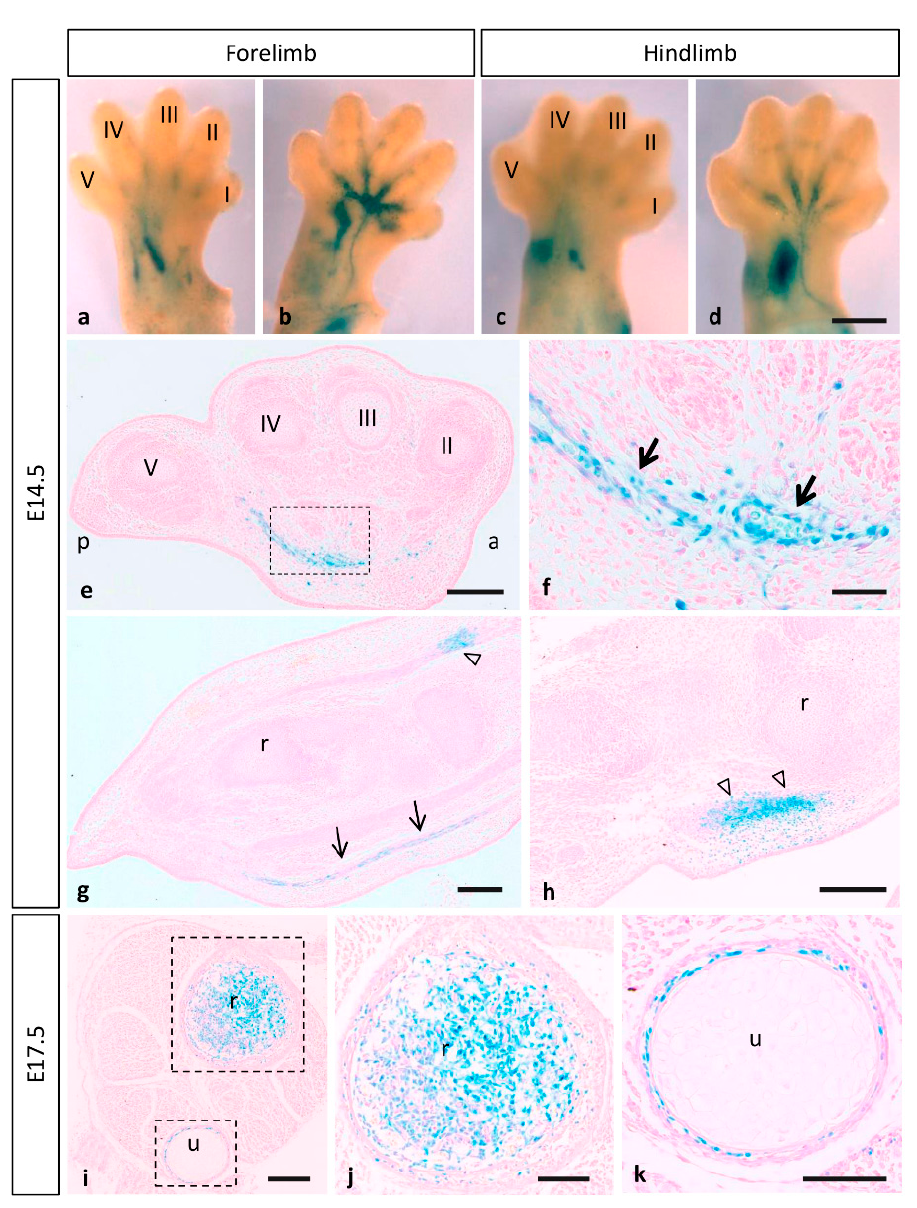
Figure 8. Mt1-mmp LacZ/+ distribution during mouse limb development. Whole mount forelimbs (( a ), dorsal side; (( b ), ventral side) and hindlimbs (( c ), dorsal side; ( d ), ventral side) stained with β -gal show MT1-MMP expression restricted to the vasculature and muscles of the limb at E14.5. ( e – h ) Paraffin cross ( e , f ) and longitudinal sections ( g , h ) through the hindlimb showed β -gal positive cells in endothelial cells of blood vessels entering the limbs (arrows in ( f , g )) and dorsally in the earliest muscle blocks (open arrowheads in ( g ) and ( h )) at E14.5. ( i – k ) Limb crossed sections at the level of proximal radius and ulna revealed LacZ expressing cells related to the ossification within the cartilage primordium of these bones at E17.5. Abbreviations: a, anterior; p, posterior; r, radius; u, ulna; digits I, II, III, IV and V. Scale bars: 500 µ m ( a – d ), 200 µ m ( e , g – i ), 100 µ m ( j , k ), 50 µ m ( f ). Our results are in line with previous evidence showing that MT1-MMP is promi- nently expressed in embryonic connective tissue cells such as osteoblasts, osteoclasts and perichondrial, muscle and tendon fibroblasts [17,96,97]. Knock-out MT1-MMP display several craniofacial abnormalities linked to shorter bones due to delayed vascular develop- ment as well as several skeletal and extra skeletal connective tissues disorders [13,24,25]. In addition, previous studies have revealed that double deficiency for MT1-MMP